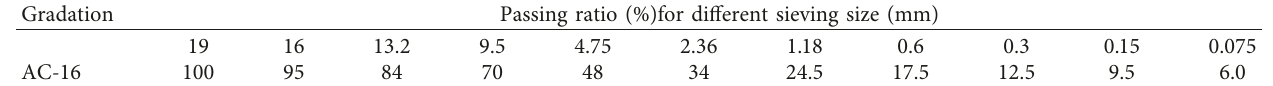
Table 2: Gradations for AC-16.